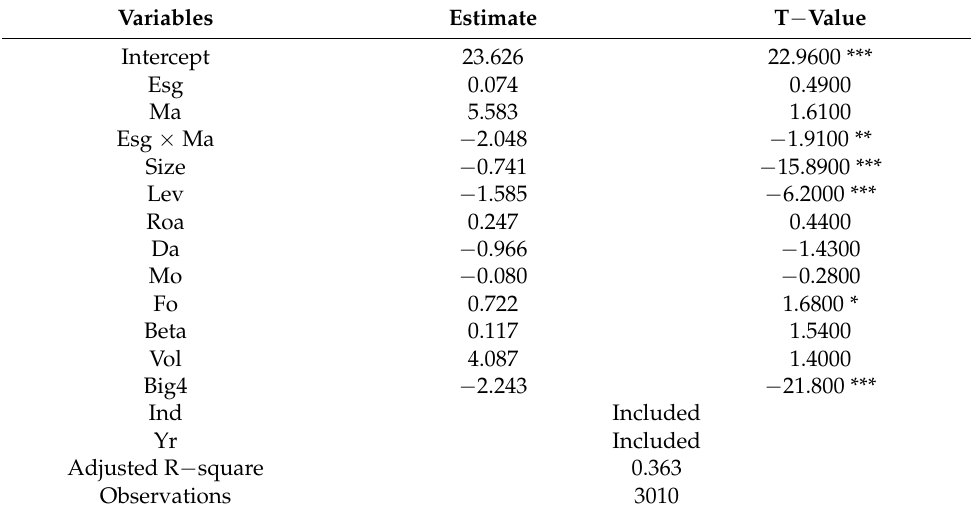
Table 5. The effect of managers’ ability on the relationship between ESG and audit hours. Variables